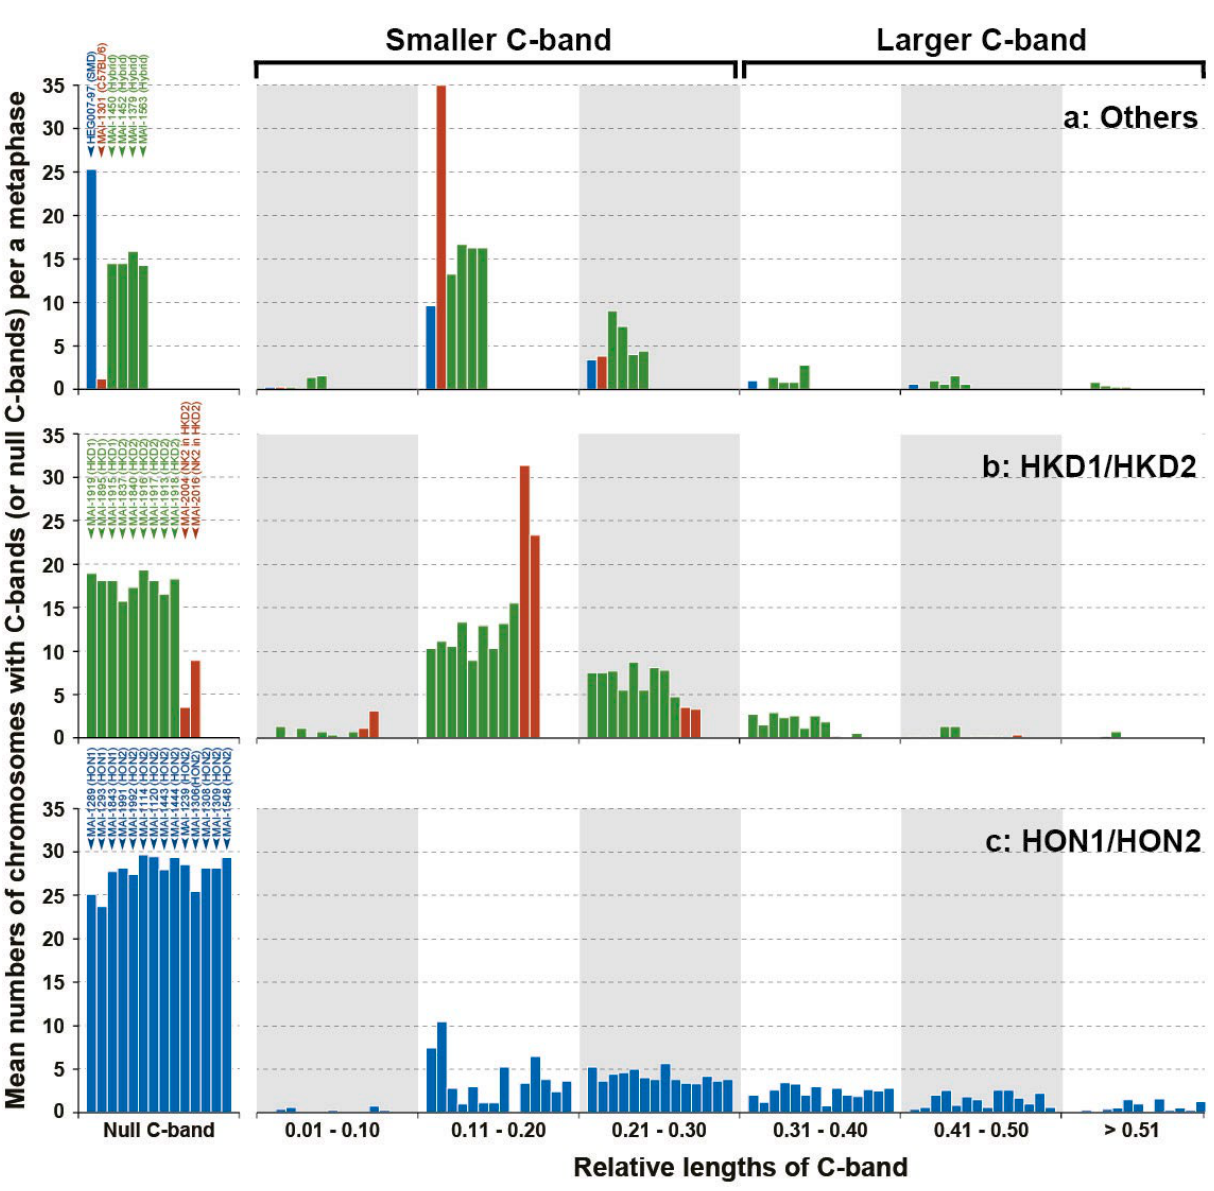
Fig. 4. Histograms showing mean numbers of chromosomes without C-bands or with C-bands per metaphase, classified into each class of relative length with 0.01–0.10, 0.11–0.20, 0.21–0.30, 0.31–0.40, 0.41–0.50, and